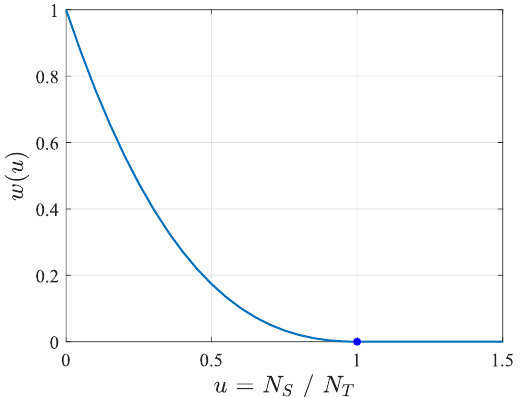
Figure 14. Expansion of box/process “select candidate triangle from B ( S ) ” from Figure 13.